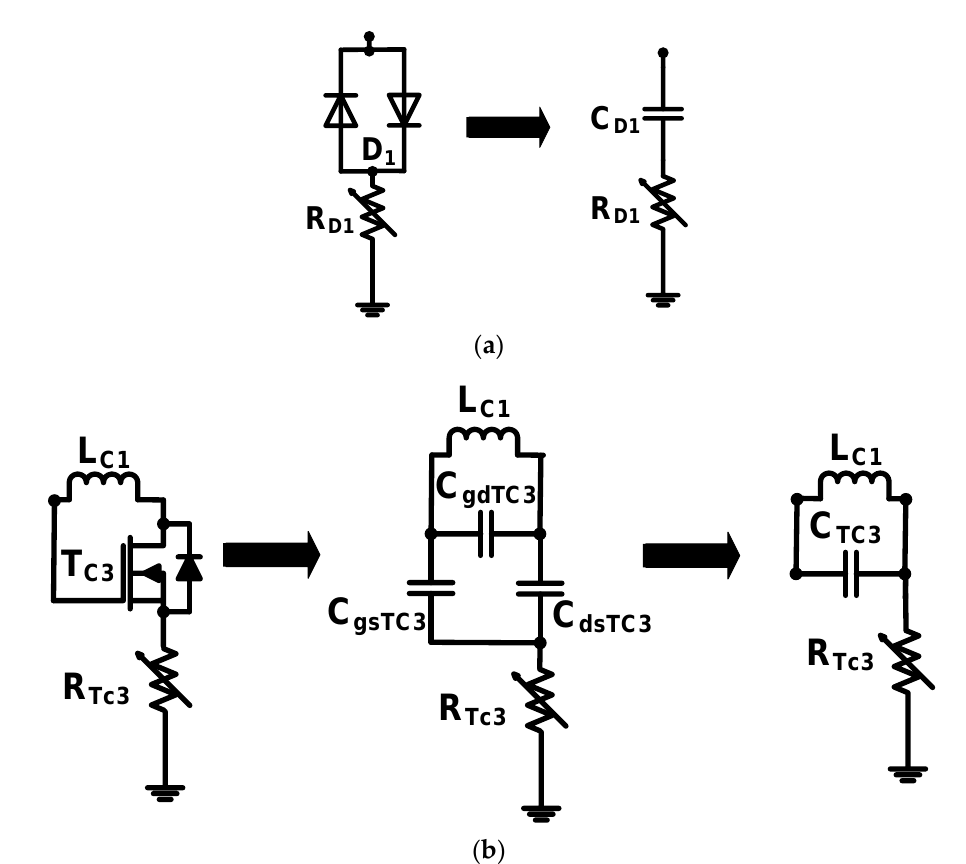
Figure 3. Equivalent circuit models of ( a ) switching diodes and ( b ) transistor.